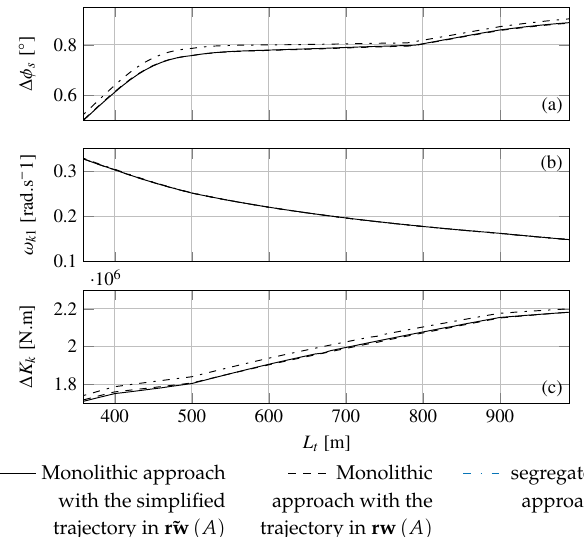
Figure 12. ( a ) Amplitude of the ship roll motion, ( b ) first kite harmonic frequency and ( c ) amplitude of the kite moment of excitation for different tether lengths from 360 m to 990 m by step length of 10 m in calm